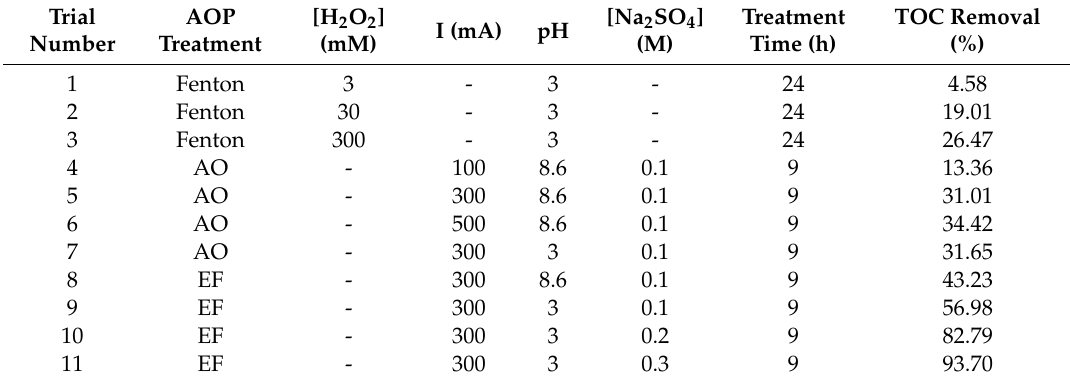
Table 5. Experimental conditions of advanced oxidation processes (AOPs) used for S-Fe regeneration and consequent TOC